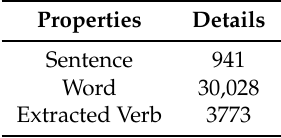
Table 6. Properties of Data set